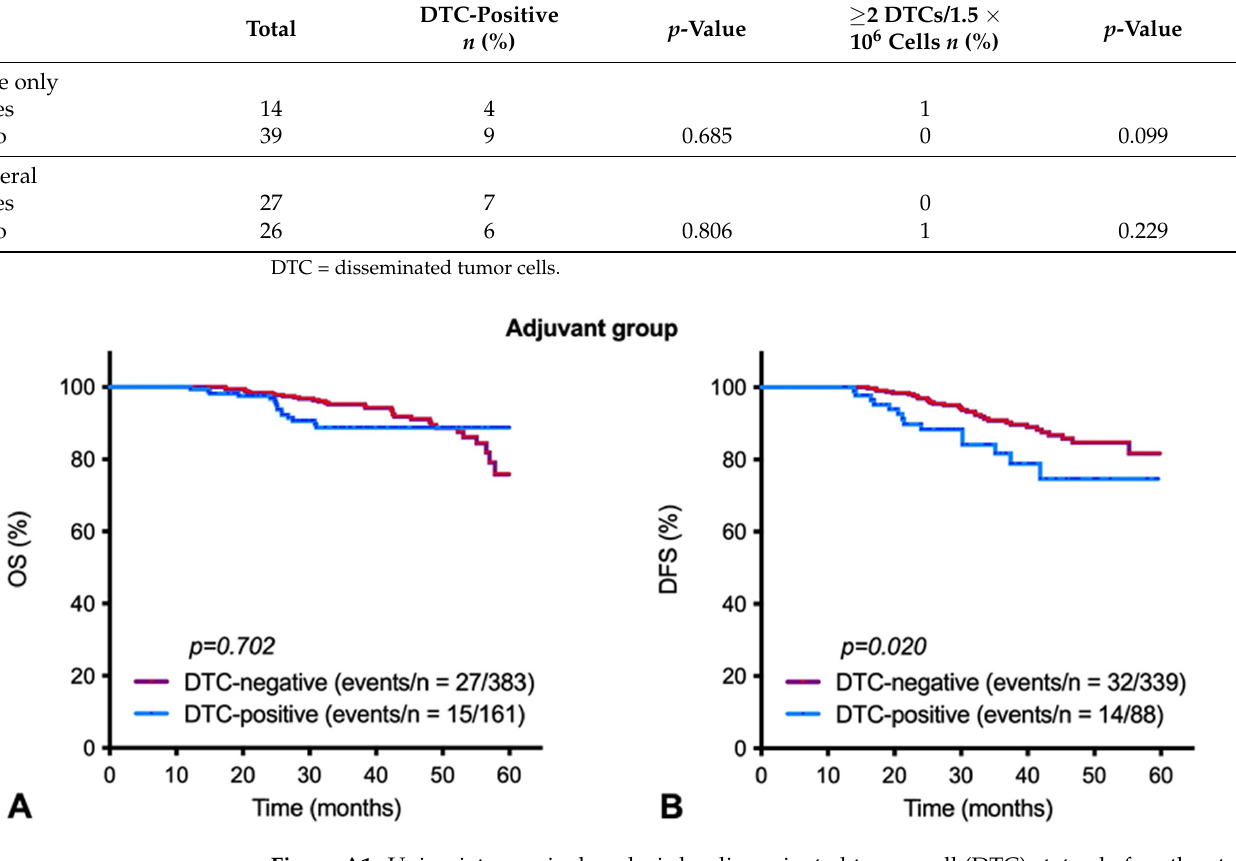
Figure A2. Quantification of disseminated tumor cells (DTCs) in patients with bone marrow aspi- ration before ( left ) and after chemotherapy ( right ). Samples were classified as DTC-negative (0 DTCs/1.5 × 10 6 mononuclear cells) or DTC-positive ( ≥ 1 DTC/1.5 × 10 6 mononuclear cells OR ≥ 2 DTCs/1.5 × 10 6 mononuclear cells OR ≥ 4 DTCs/1.5 × 10 6 mononuclear cells OR ≥ 5 DTCs/1.5 × 10 6 mononuclear cells). Figure A3. Representative images of: DTC from a patient’s sample ( left ), positive control with an SKBR-3 cell ( middle ), negative control ( right ); taken at 20× magnification.